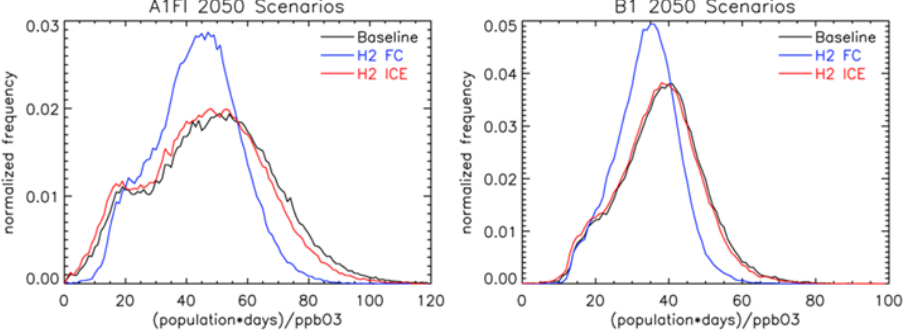
Fig. 6. Normalized probability distribution [population · days/ppb] of CMAQ simulated surface daily maximum 8h-average O 3 concentrations Figure 6. Normalized probability distribution [population*days/ppb] of CMAQ simulated 2 throughout one year for the A1FI (left) and B1 (right) baseline, H 2 -ICE, and H 2 -FC scenarios across the United States. Distributions are based on the US population distribution for 2000 and the bin interval is surface daily maximum 8-hour-average O (left) and B1 (right) Baseline, H Distributions are based on the U.S. population distribution for 2000 and the bin interval is 1 5 ppbv. 6